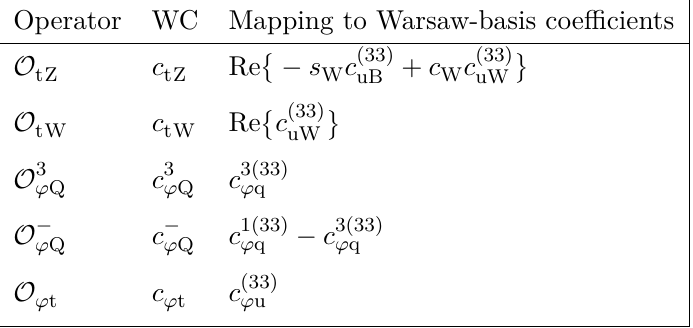
Table 1 . List of dimension-six EFT operators considered in this analysis and their corresponding WCs. The linear combinations of WCs to which they correspond in the Warsaw basis are indicated. The abbreviations s and c denote the sine and cosine of the weak mixing angle, respectively. W W The definitions of the relevant Warsaw-basis operators can be found in ref.